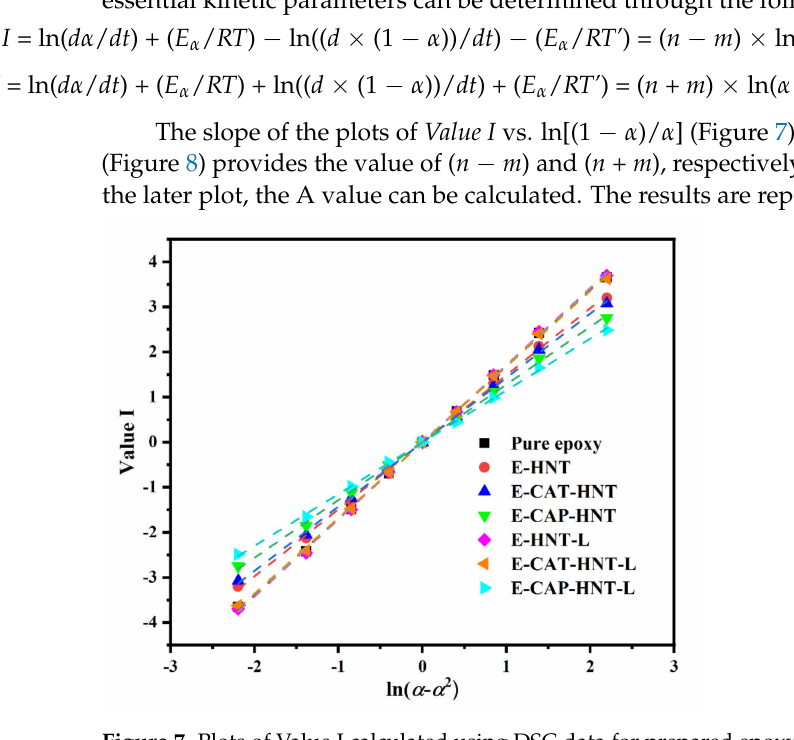
Figure 7. Plots of Value I calculated using DSC data for prepared epoxy system under heating rate of 5 ◦ C/min.